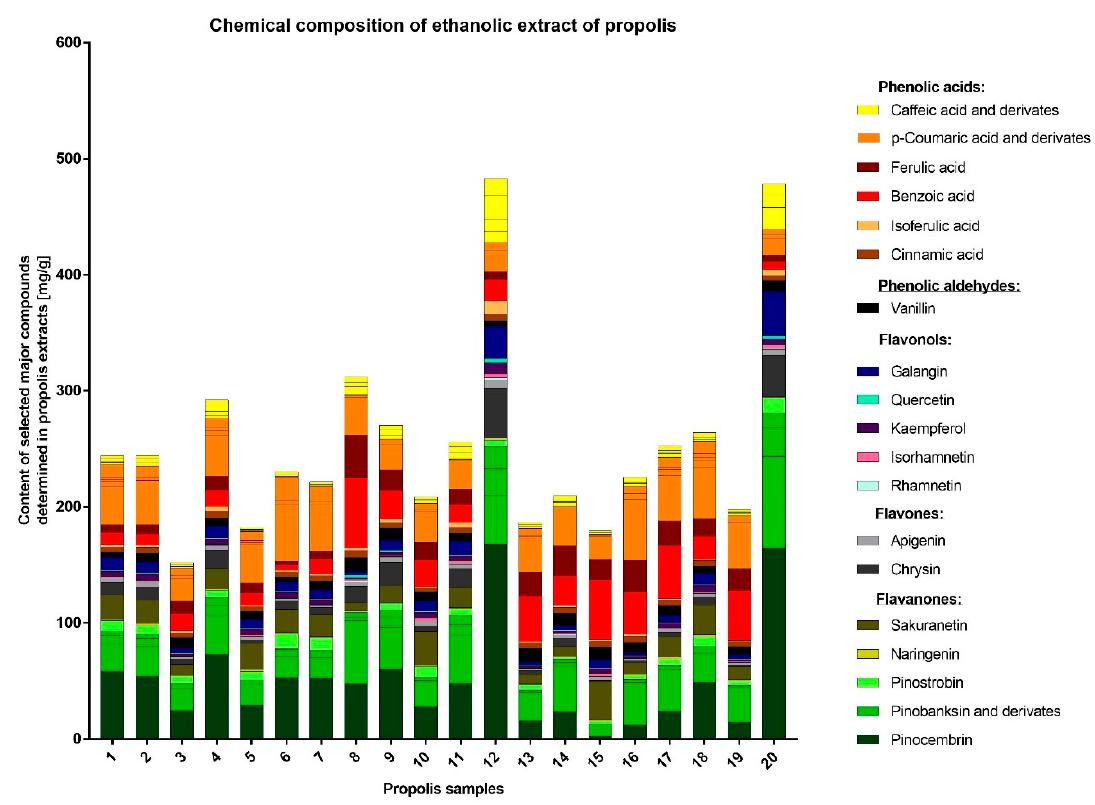
Figure 3. The chemical composition of investigated EEPs.